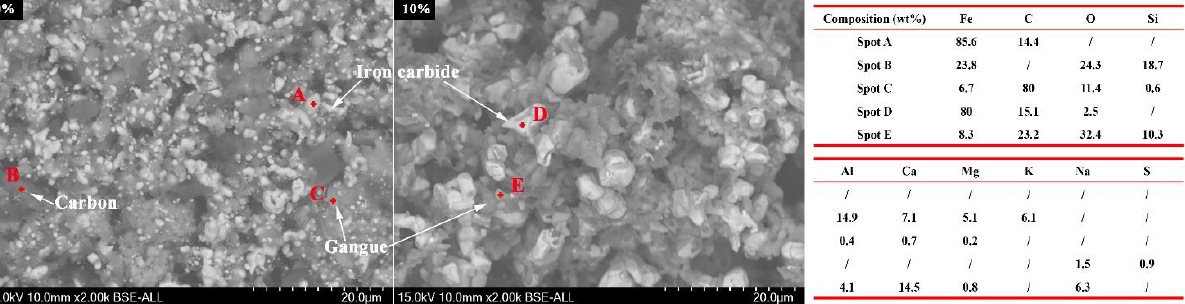
Figure 6. SEM-EDS images of the pellets carburized at 650 °C for 150 min with different weight percentages of Na 2 SO 4 (iron carbide: white; gangue: gray; carbon and pore: black).